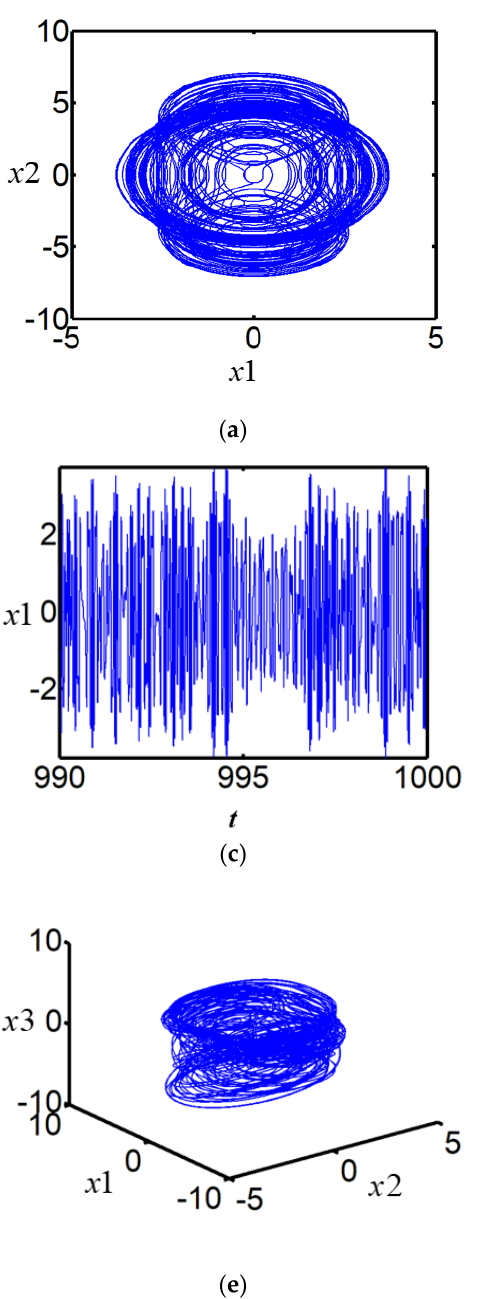
Figure 1. Chaotic motion in nonlinear nonplanar vibration for the cantilever beam: ( a ) phase portrait on the plane ( x 1 , x 2 ) ; ( b ) phase portrait on the plane ( x 3 , x 4 ) ; ( c ) waveform on the plane ( t , x 1 ) ; ( d ) waveform on the plane ( t , x 3 ) ; ( e ) phase portrait in the three-dimensional space ( x 1 , x 2 , x 3 ) ; ( f ) Poincare maps on the plane ( x 1 , x 2 ) .